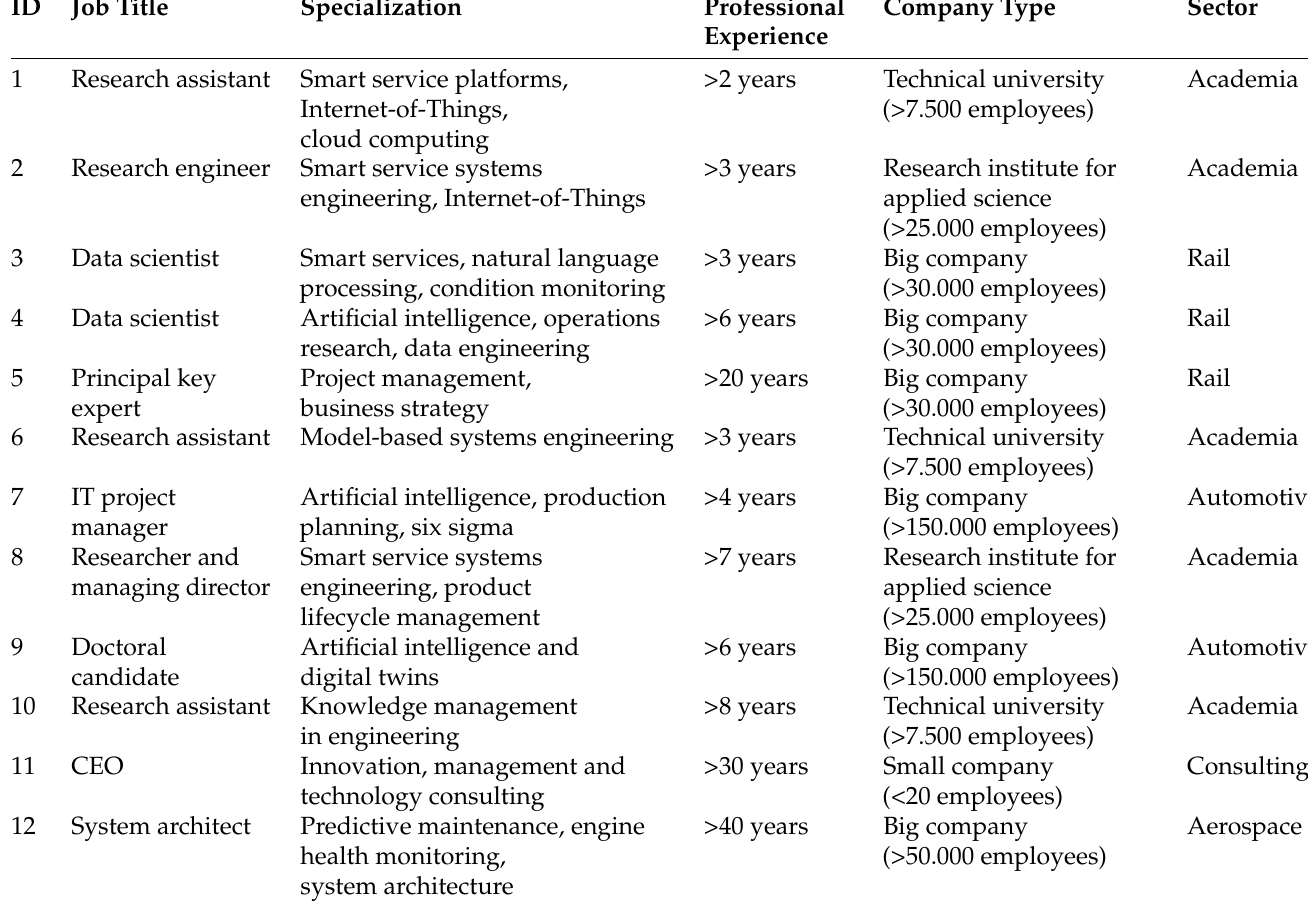
Table 4. Profiles of experts consulted for evaluation of the SemDaServ